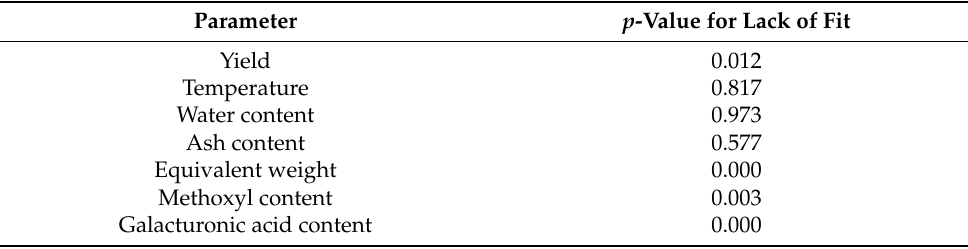
Table 3. Lack of fit test results.